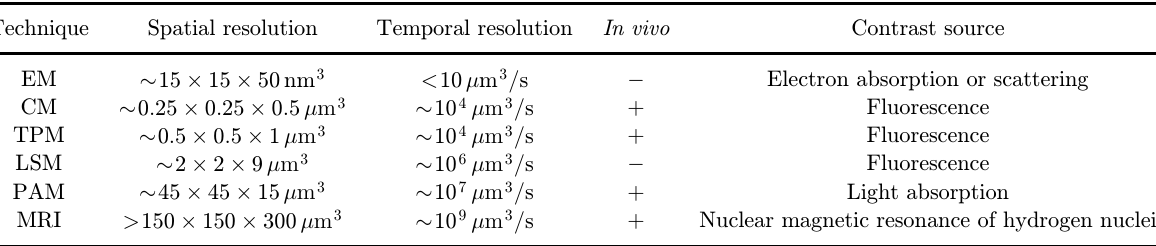
Table 1. Comparison of di®erent techniques for structural and functional brain imaging.